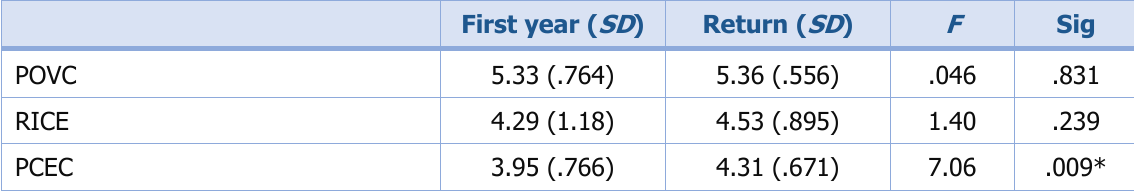
Table 3: Pre-Camp Differences Between First-Year (n = 44) and Returning Counselors’ (n = 69) Creativity